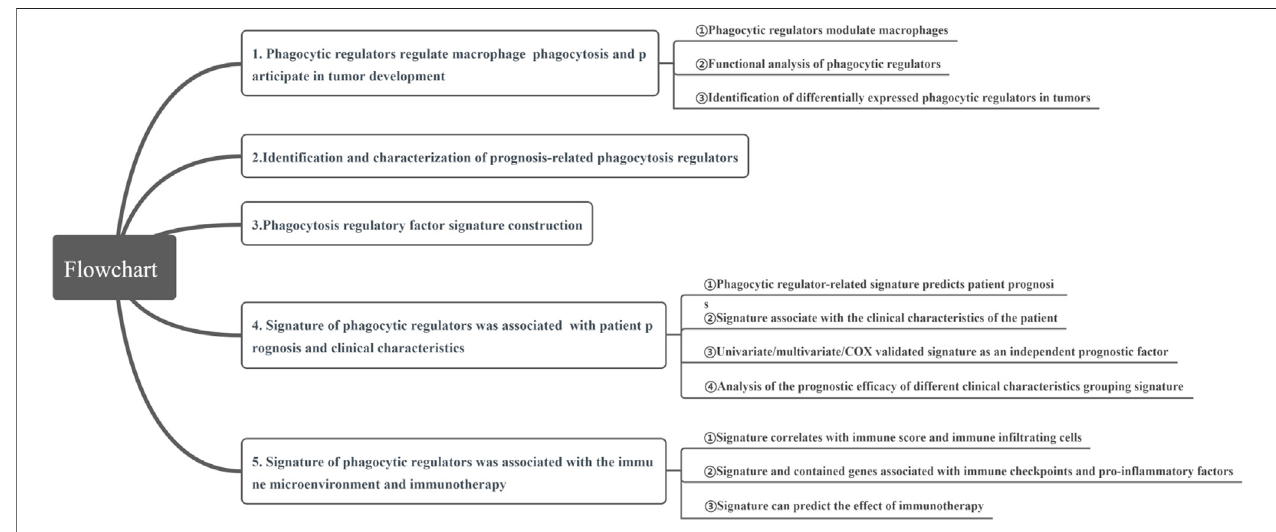
FIGURE 1 | The fl owchart of this